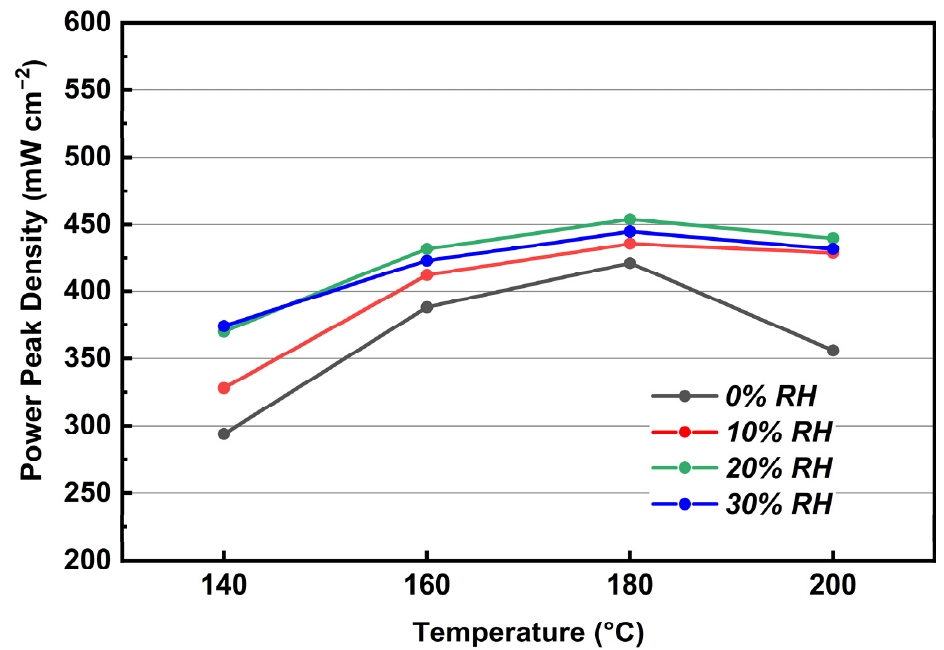
Figure 14. Peak power density at 140–200 °C under various levels of relative humidity. (Equal H 2 and O 2 flow rates at 0.4 L min − 1 ).